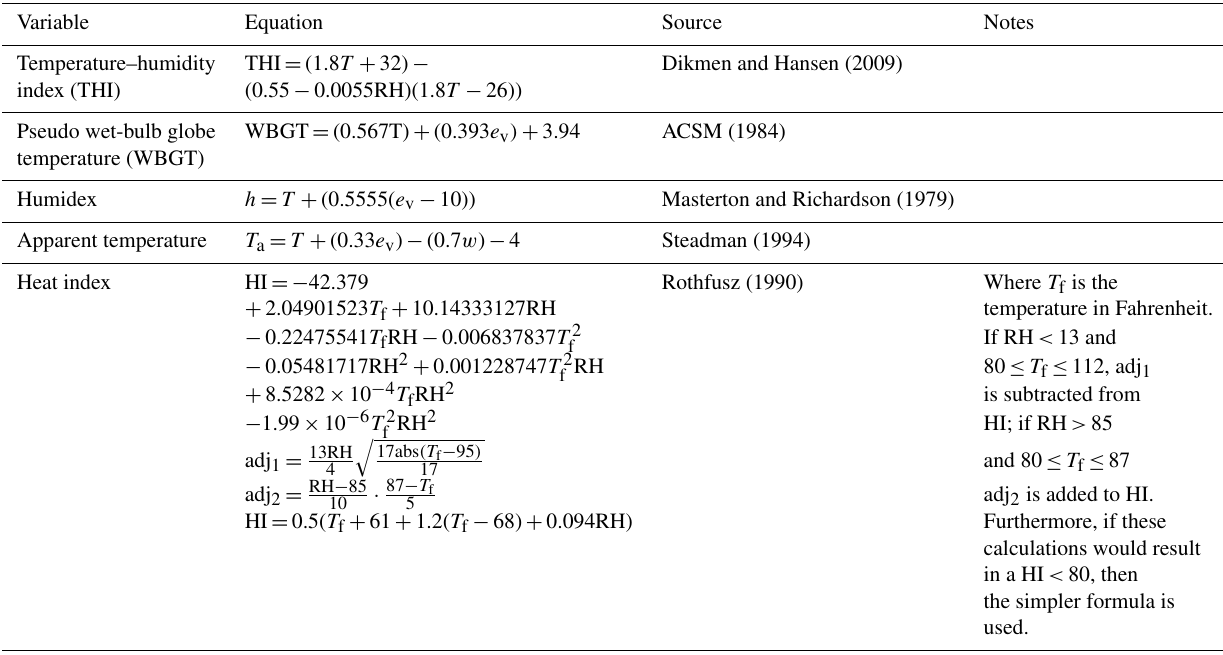
Table 6. Heat stress measures calculated in HadISD